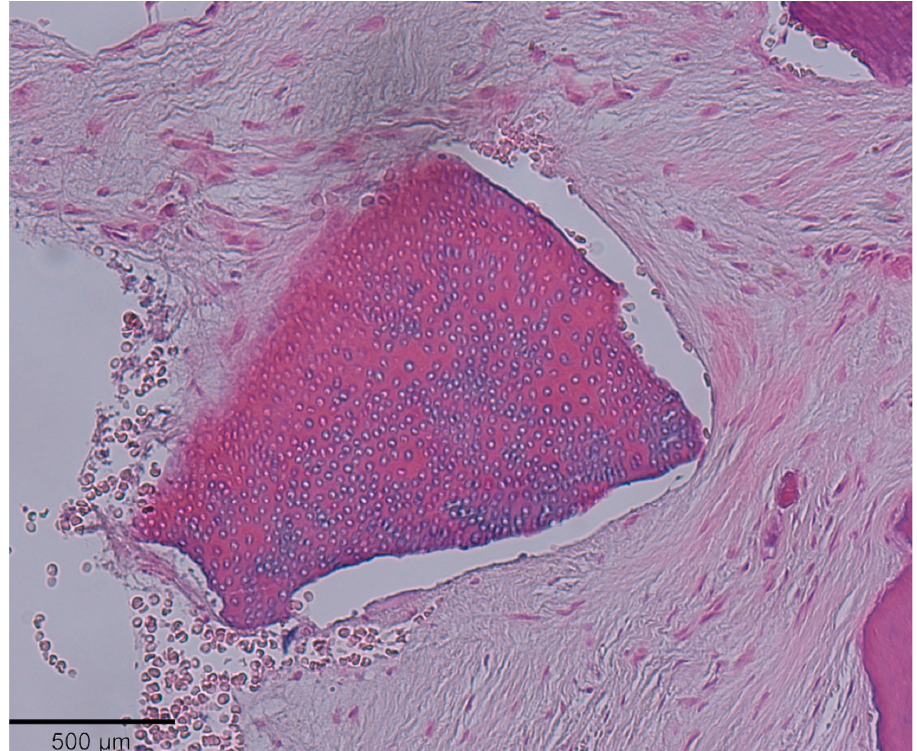
Figure 8. Histologic image at twelve months with a high magnification of dentin particles showing a layer of new bone on top of the dentin particles with open dentin tubes.